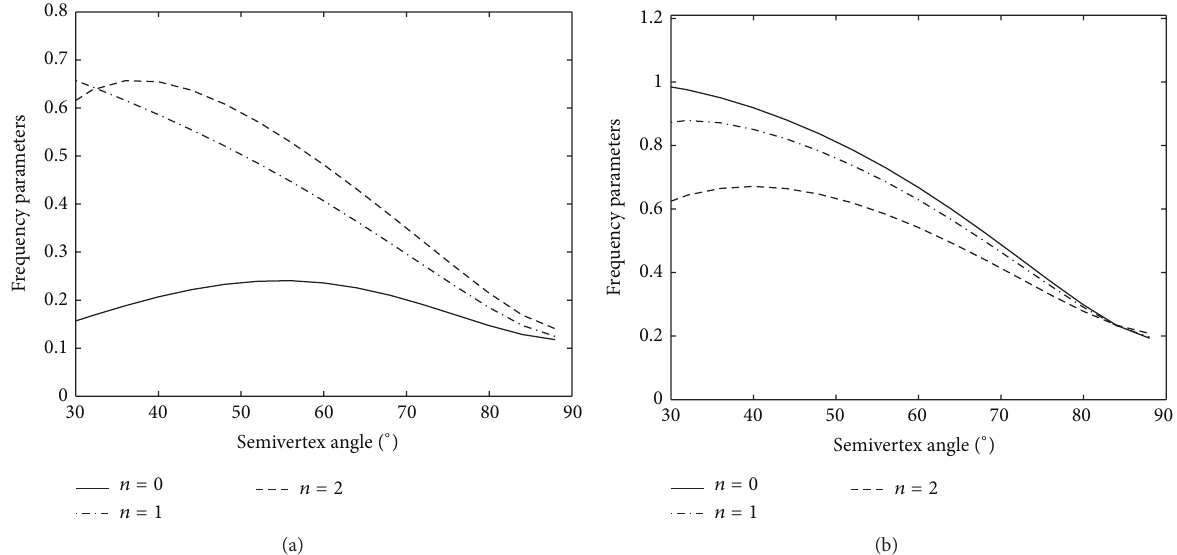
Figure 8: Natural frequency parameters of the conical shell with the variation of semivertex angle ( ℎ/𝑅 2 = 0.01 , 𝐿 sin 𝑎/𝑅 2 = 0.5 ; (a) S-S, (b)